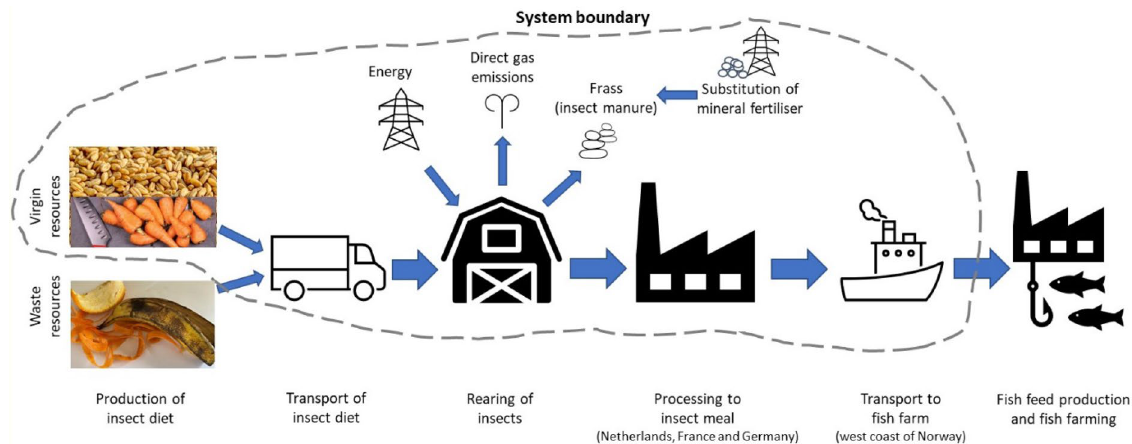
Fig. 1 System boundaries for the insect protein value